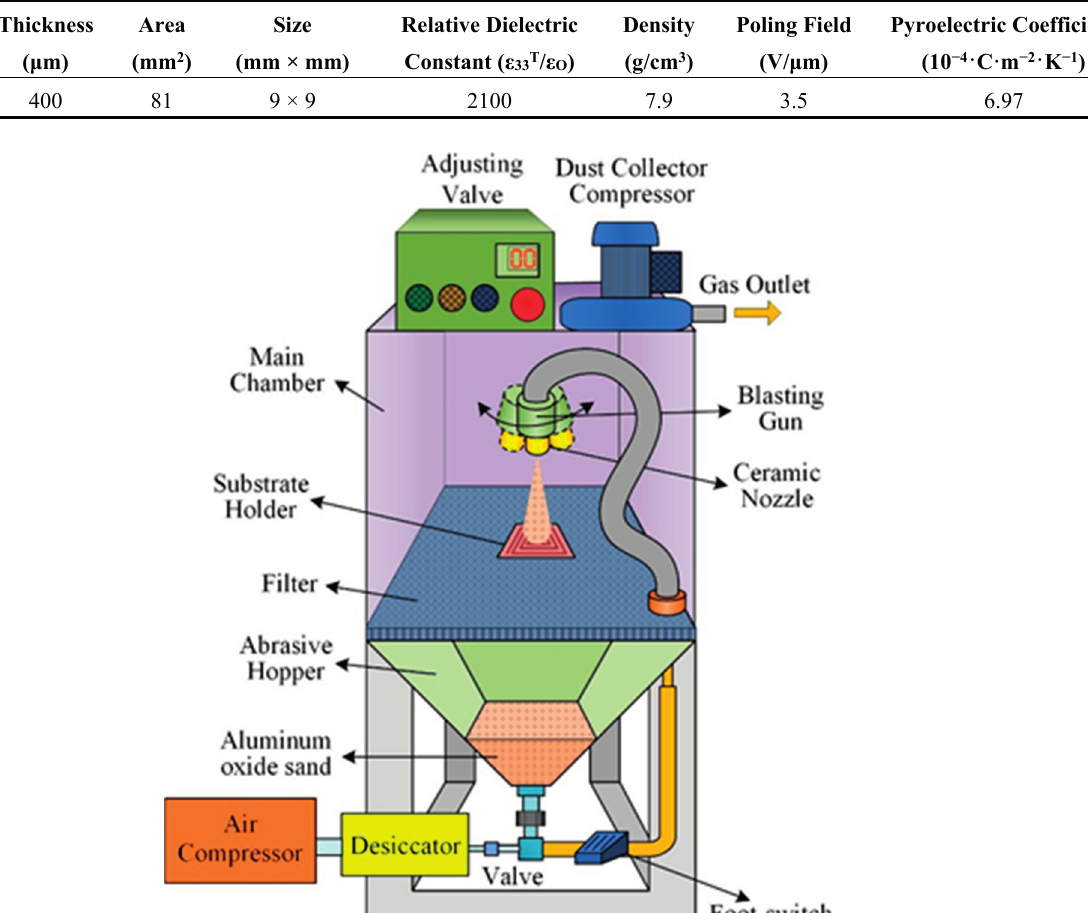
Table 1. Properties of the commercial PZT pyroelectric sheet.